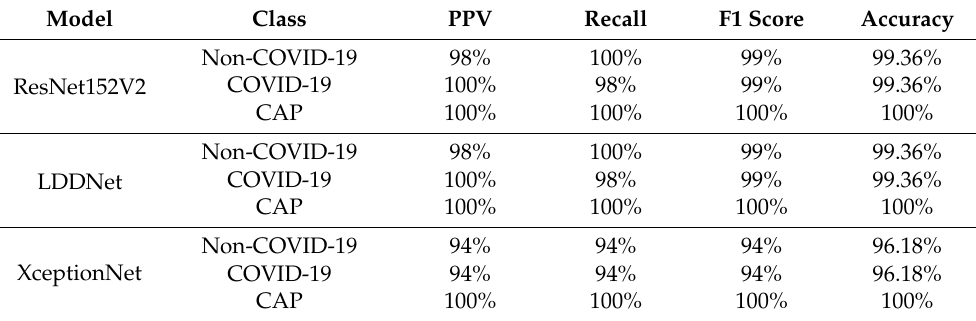
Table 5. Comparison of different DL models for the Adam